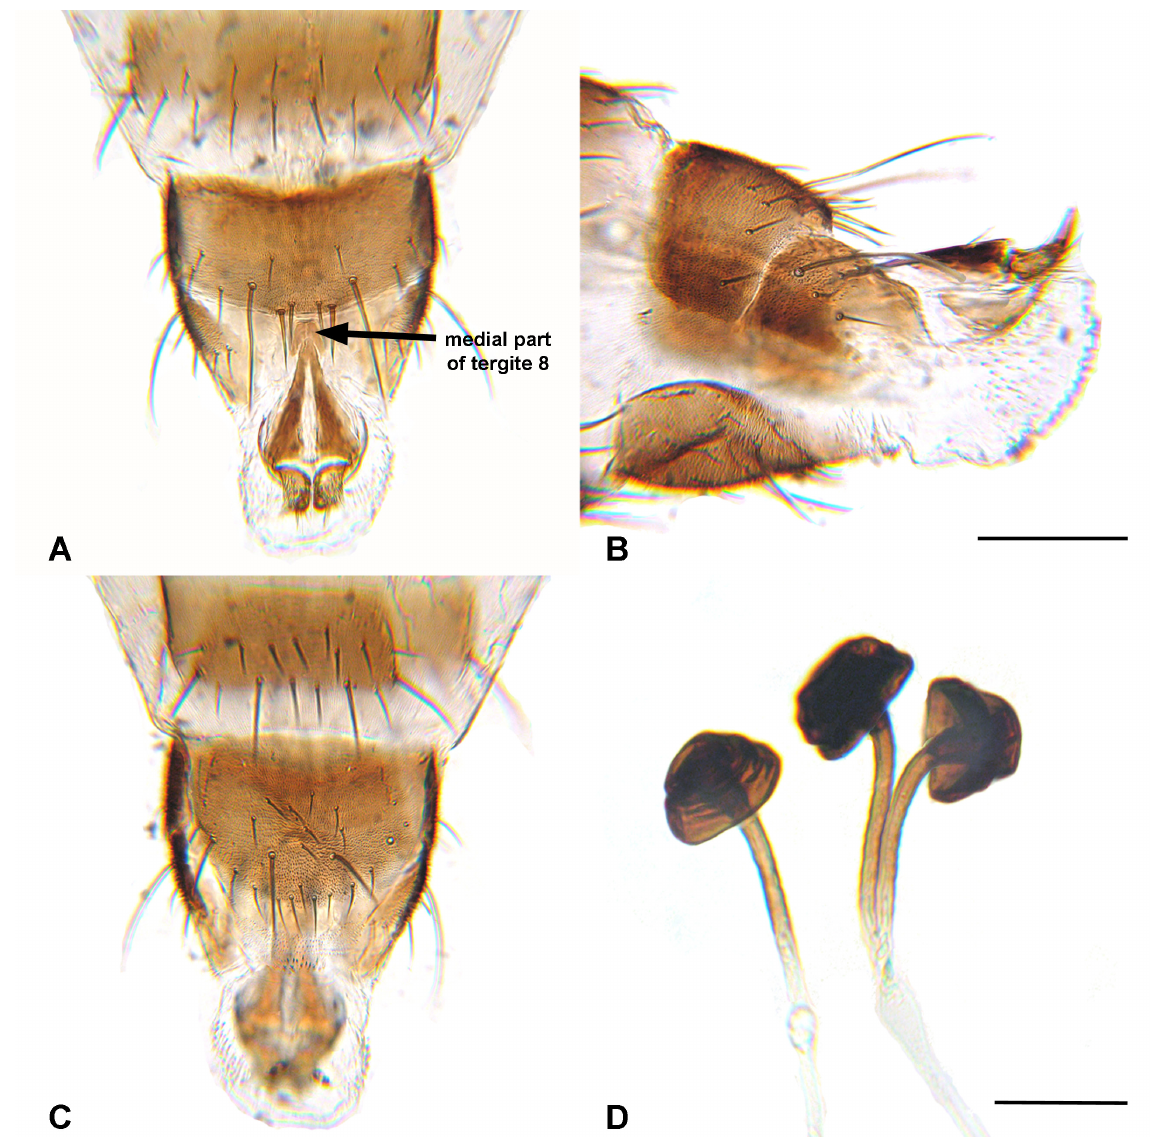
Fig. 15. Rudolfina newtoni sp. nov., female terminalia (debu01086226). A . Terminal abdominal segments, dorsal view. B . Same as preceding, lateral view. C . Same as preceding, ventral view. D . Spermathecae. Scale bars: A–C = 0.10 mm; D = 0.04